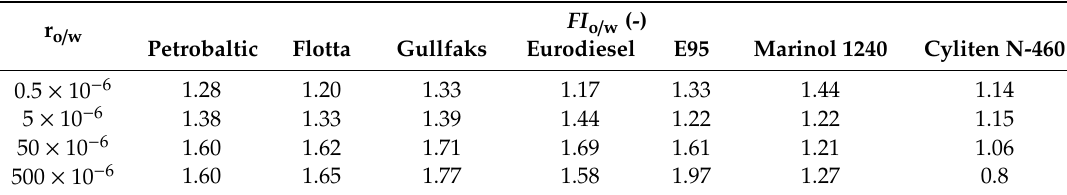
Table 4. Fluorometric index ( FI o / w ) calculated by Formula (2) for the seawater contaminated with individual oils on 15 April 2019.